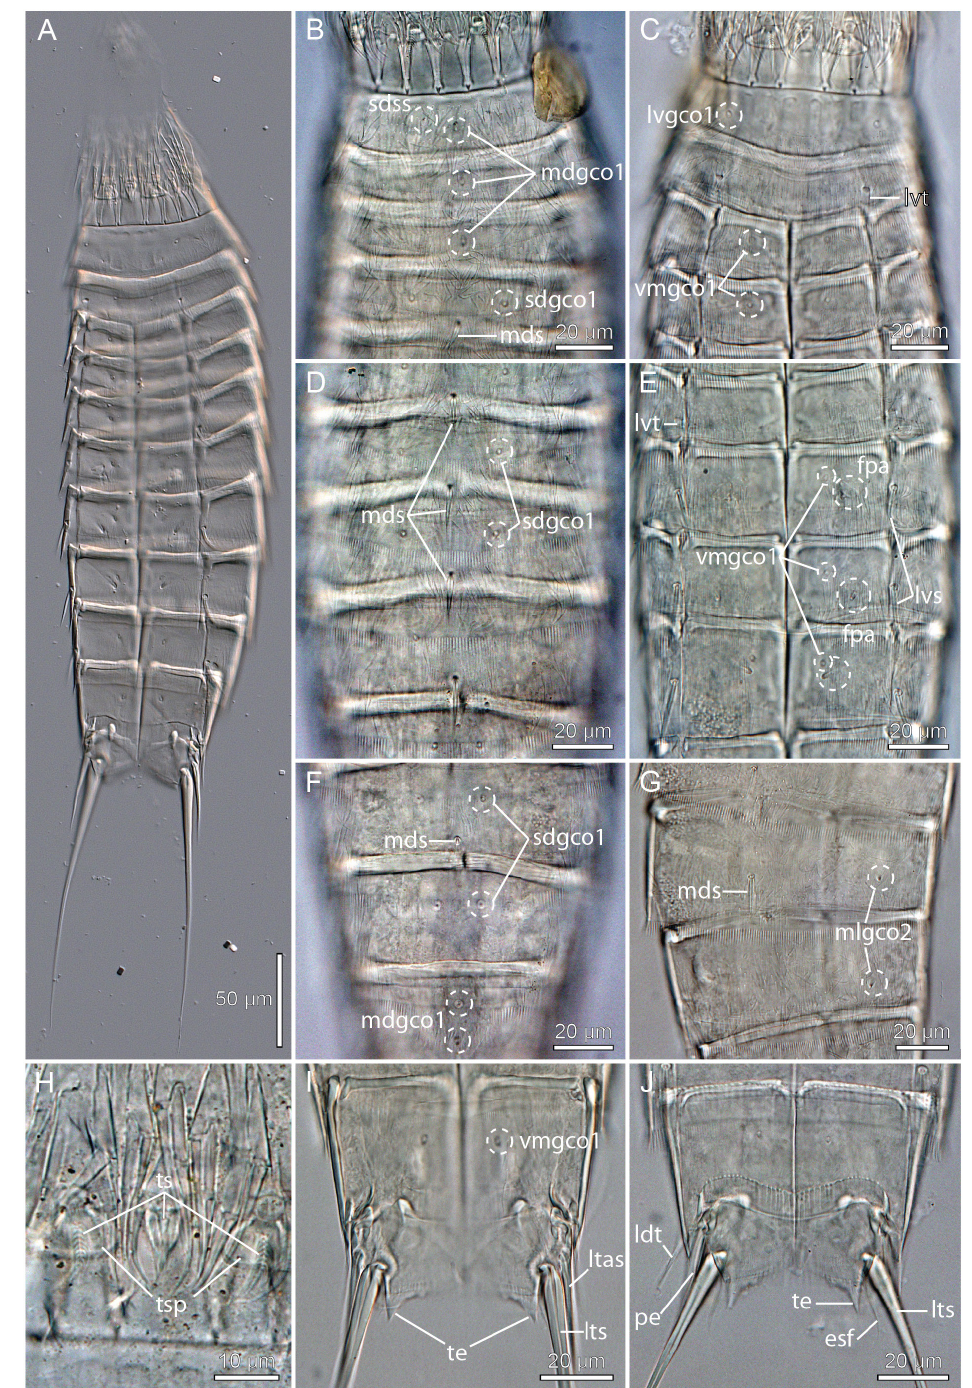
Fig. 14. Light micrographs showing overviews and details of Echinoderes sensibilis Adrianov et al ., 2002. A–I . ♀. A . ICHUM-6127. B–F, I . NHMD-662049. G . NHMD-662066. H . NHMD-662060. A . Ventral overview. B . Segments 1 to 4, dorsal view. C . Segments 1 to 4, ventral view. D . Segments 5 to 8, dorsal view. E . Segments 5 to 8, ventral view, showing female sexual dimorphism. F . Segments 8 to 10, dorsal view. G . Segments 8 to 9, dorsal view. H . Detail showing ventral trichoscalids and trichoscalid plates. I . Segments 10 to 11, ventral view, showing female sexual dimorphism. J . ♂ (NHMD-662056). Segments 10 to 11, ventral view, showing male sexual